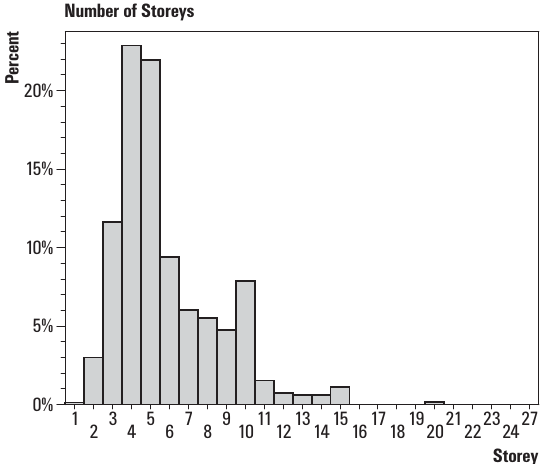
Figure 6. Housing type of the houses Figure 5. Number of storeys of the